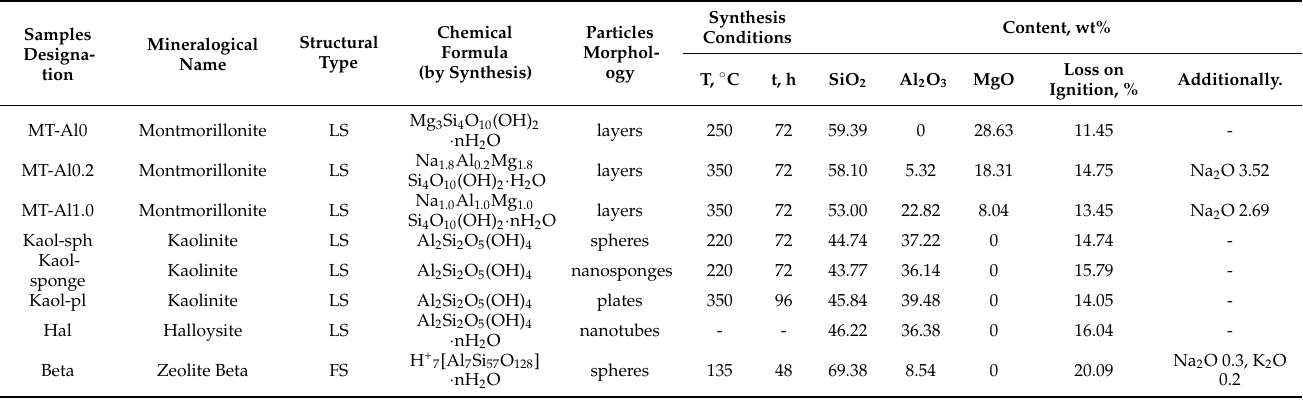
Table 1. Main characteristics of the studied